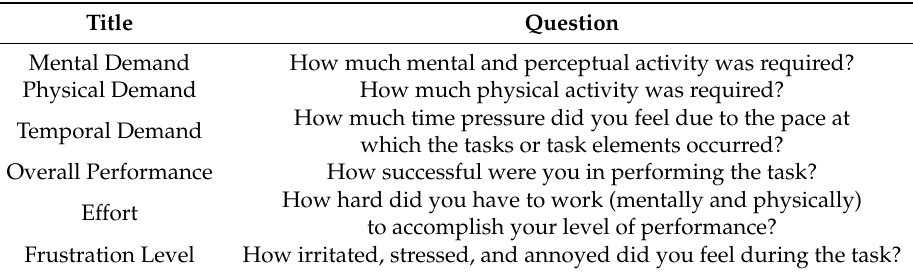
Table 2. The NASA Task Load Index (NASA-TLX)